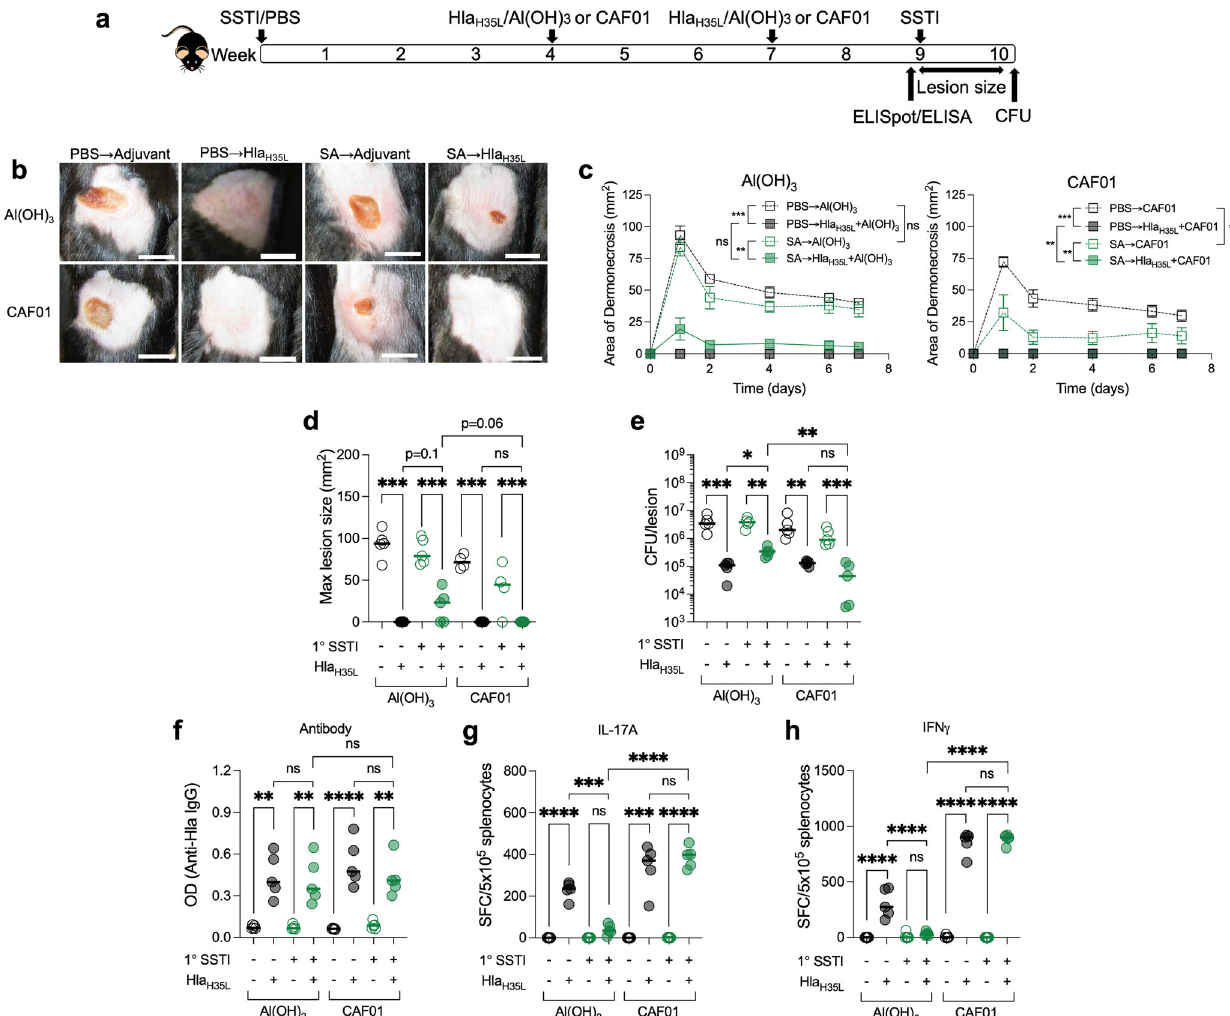
vaccination with Hla H35L adjuvanted with Al(OH) 3 or CAF01. Vaccination was followed by secondary SSTI with WT S. aureus or quanti fi cation of anti-Hla IgG levels by ELISA or Hla-speci fi c T cell responses by IL-17A or IFN γ ELISpot on cultured splenocytes. b Representative photos